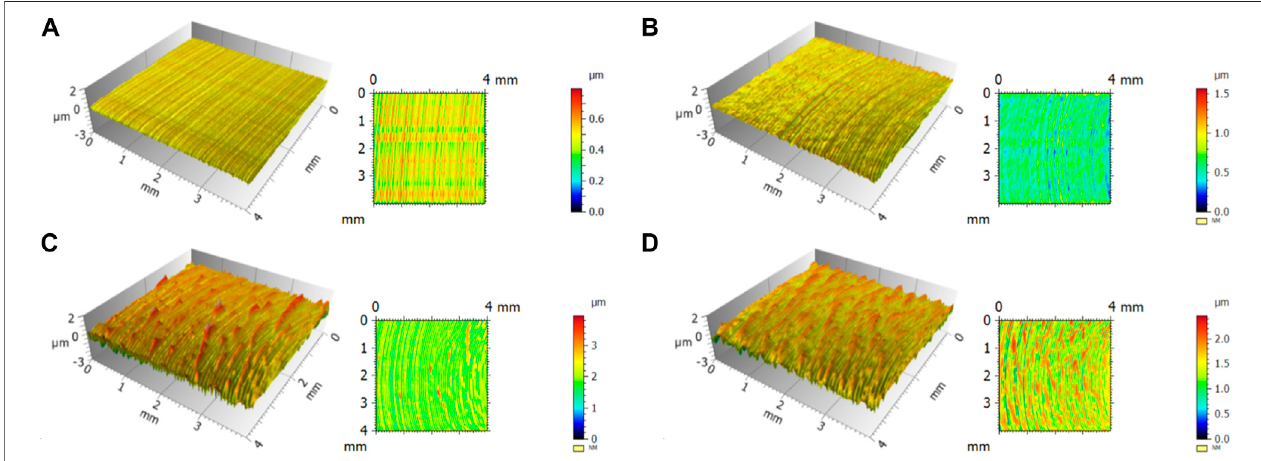
FIGURE 6 | Results of 3D topography measurements for Vancron 40 steel after: (A) G, (B) T, (C) T + B150, (D) T + B180.